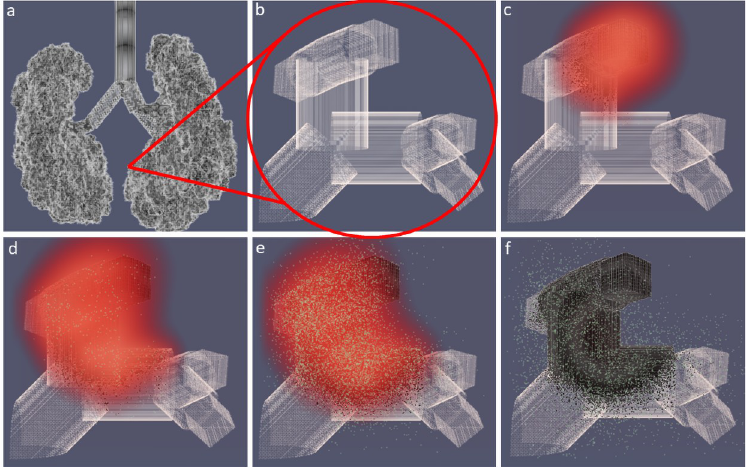
Fig 7. Simulated 3D branching airway with a single FOI. (A) shows the full lung model; (B) – (F) show T cells (green), virions (red), and a small region of epithelial cells (gray) at (B) 0 dpi, (C) 4.2 dpi, (D) 6.3 dpi, (E) 6.9 dpi, and (F) 8.3 dpi. Dead epithelial cells are indicated in black. A video corresponding to these images is available at https://